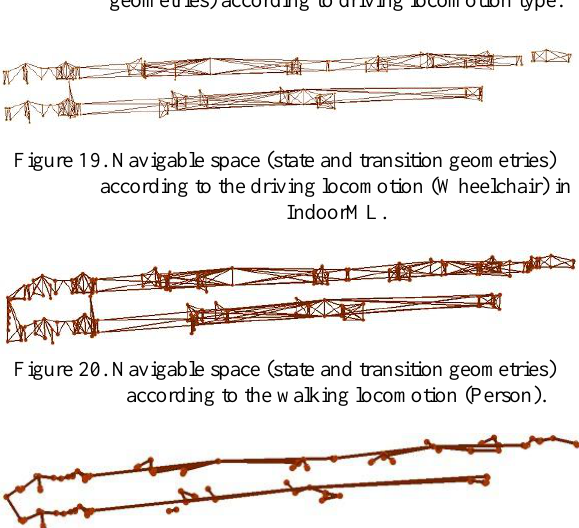
Figure 18. Navigbale space (space, state, and transition geometries) according to driving locomotion type.